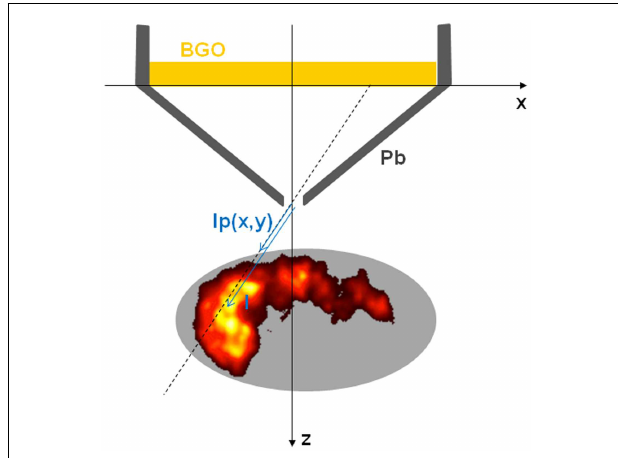
FIGURE 6 | Coordinates convention for the pinhole collimator line of response .